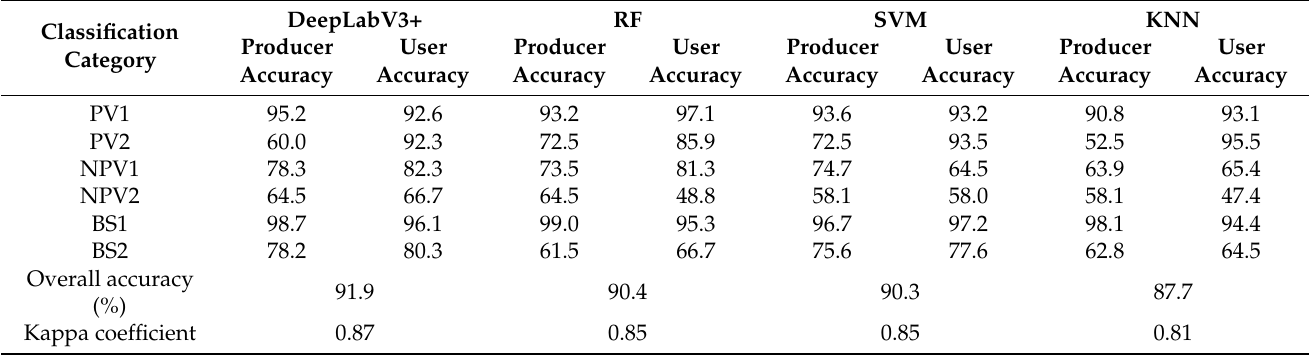
Table 3. Comparison of deep learning and machine learning methods for object classification accuracy at all locations.